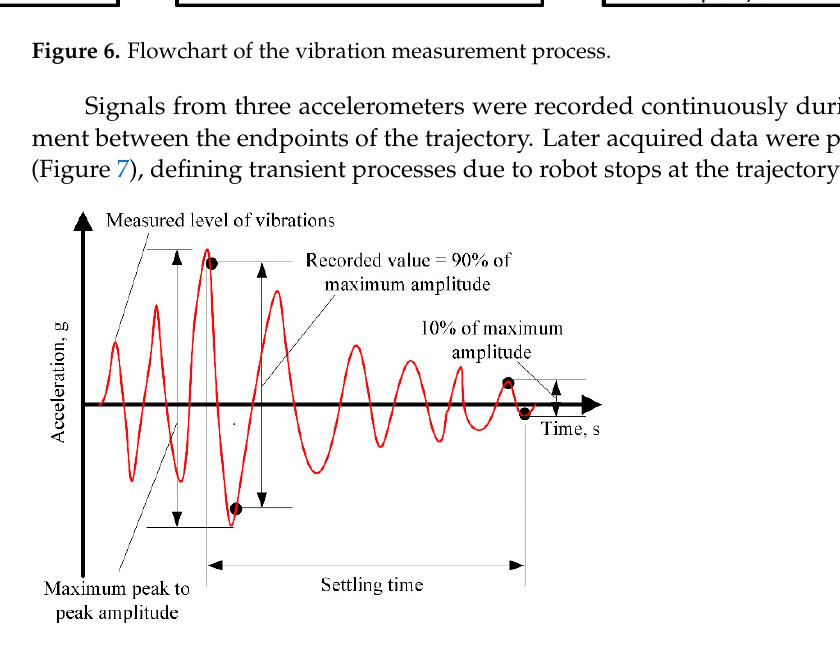
Figure 7. Definition of vibration parameters from experimental data.